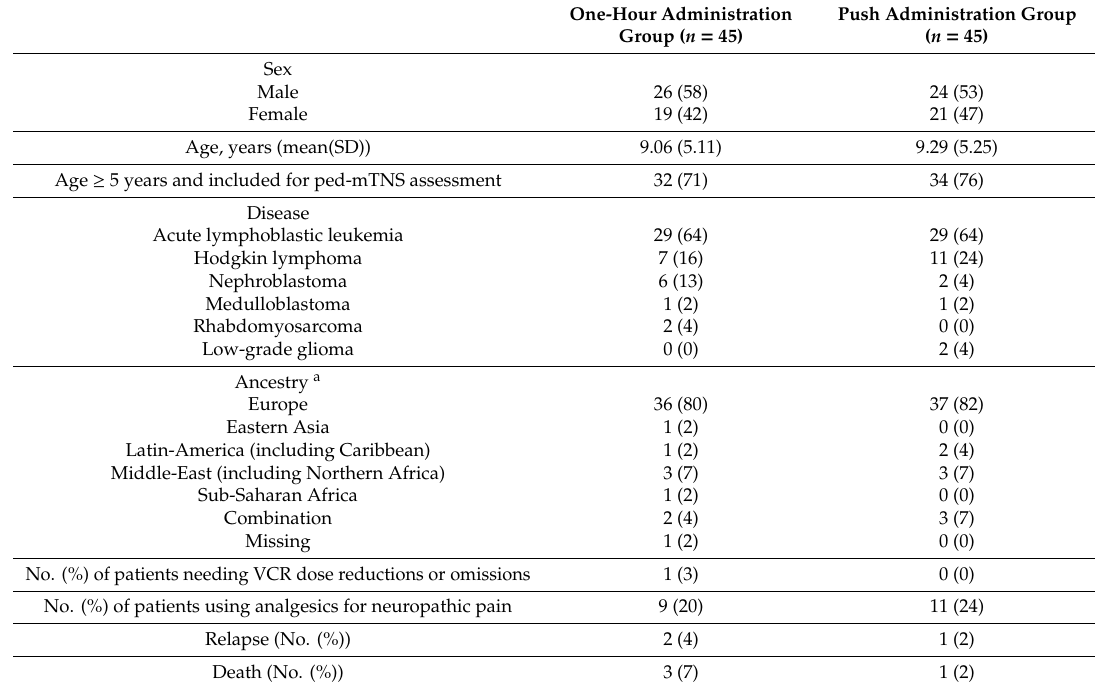
Values represent the number (%) of participants, unless indicated otherwise. SD: standard deviation; ped-mTNS: pediatric modified Total Neuropathy Score; VCR: vincristine, a : Ancestry was self- or parent-reported; participants could only be included in one category.